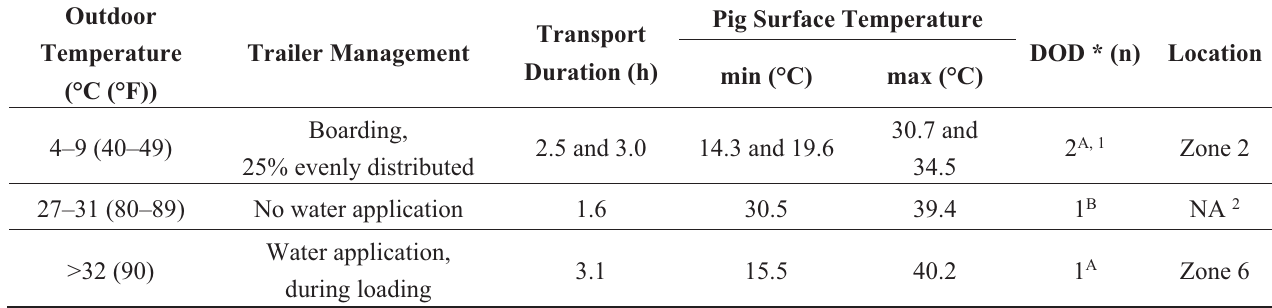
Table 4. Summary of pigs dead or down (DOD) for all monitoring trips with the trailer managed according to TQA guidelines. All pigs were visually inspected by the trailer operator to confirm the status of no signs of health or behavior abnormalities prior to loading onto the trailer. Pigs with compromised conditions were rejected before they stepped onto the